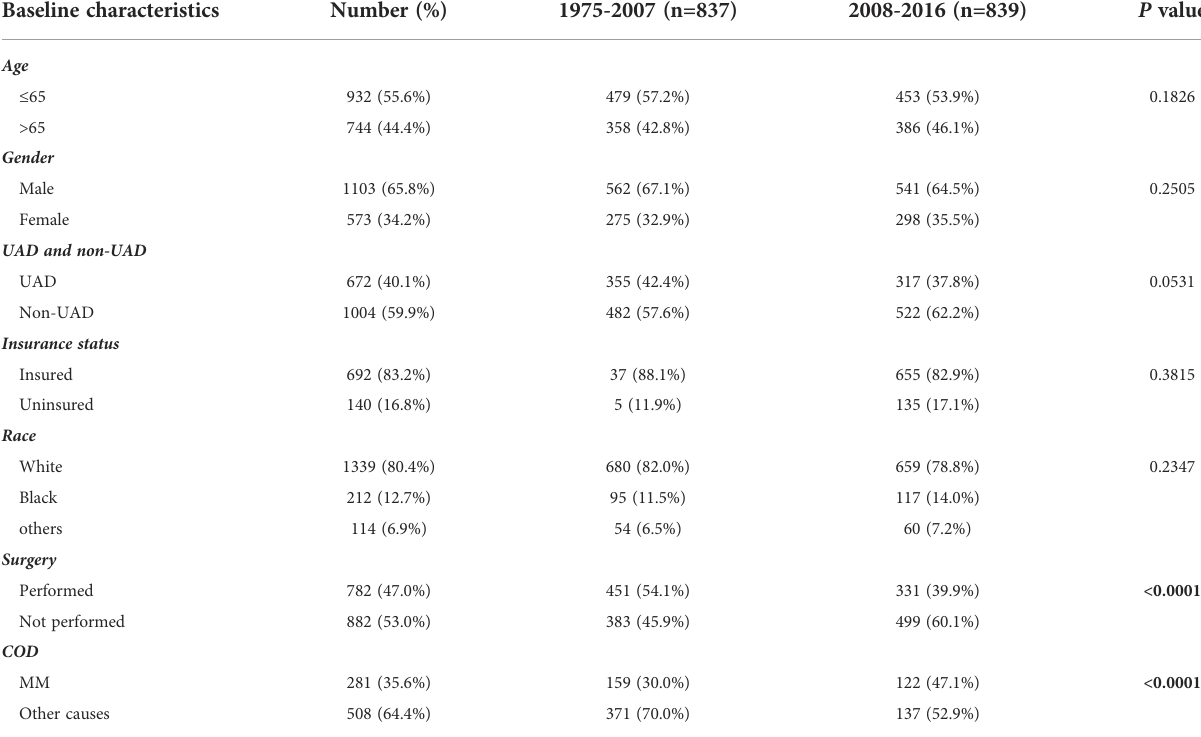
TABLE 1 Baseline characteristics of patients with